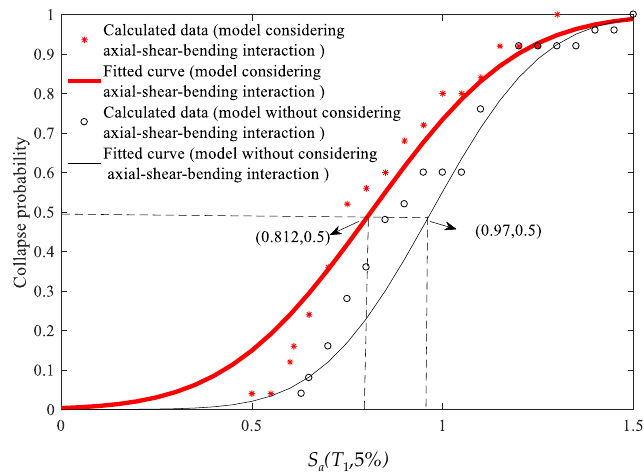
Figure 18. Collapse probability curves.